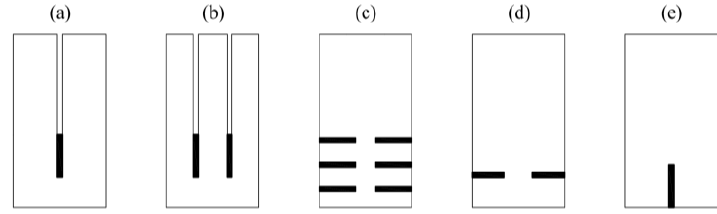
Figure 5. Methods of strengthening solid wood with FRP in incisions—( a ) one-internal vertical, ( b ) two-internal vertical, ( c ) six-edge horizontal, ( d ) two-edge—horizontal, ( e ) one-edge vertical.